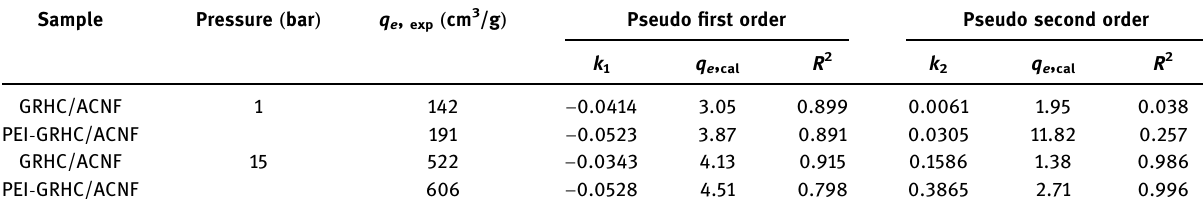
Table 9: The fi tted parameters of pseudo fi rst order and pseudo second order of PEI - GRHC/ACNFs and GRHC/ACNFs at 1 and 15 bar Sample